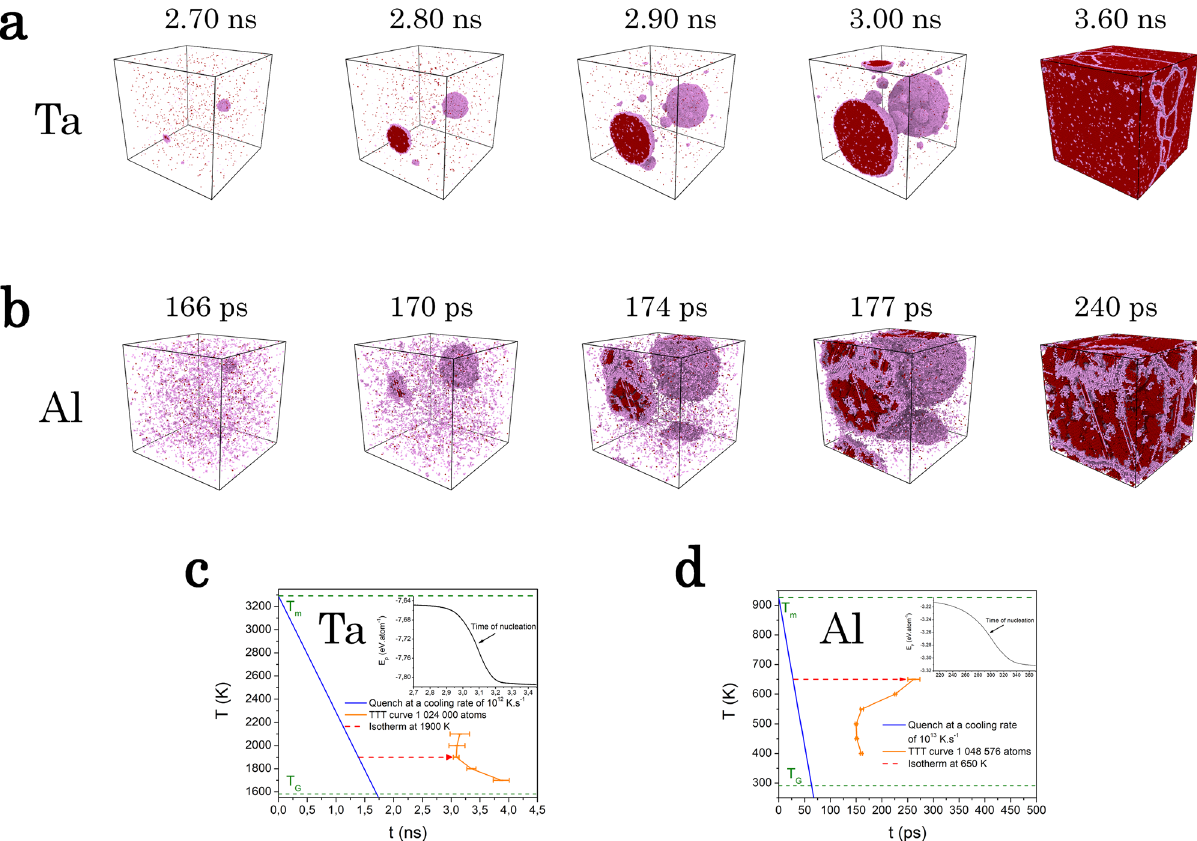
Figure 2. Homogeneous nucleation in Ta and Al undercooled liquids. Snapshots of the molecular dynamics simulations for Ta ( a ) and Al ( b ) with respectively 10 and 1 million atoms, during isothermal nucleation at different times at temperatures close to the nose of the Time-Temperature Transformation (TTT) for Ta ( c ) and Al ( d ). From stored configurations during fast cooling (blue curves), nucleation events along several isotherms were observed by monitoring the sharp drop of the internal energy (insets in ( c , d )). The average nucleation times τ N (symbols) were determined from 5 independent simulations for each temperature giving the TTT curves in the vicinity of the nose (orange